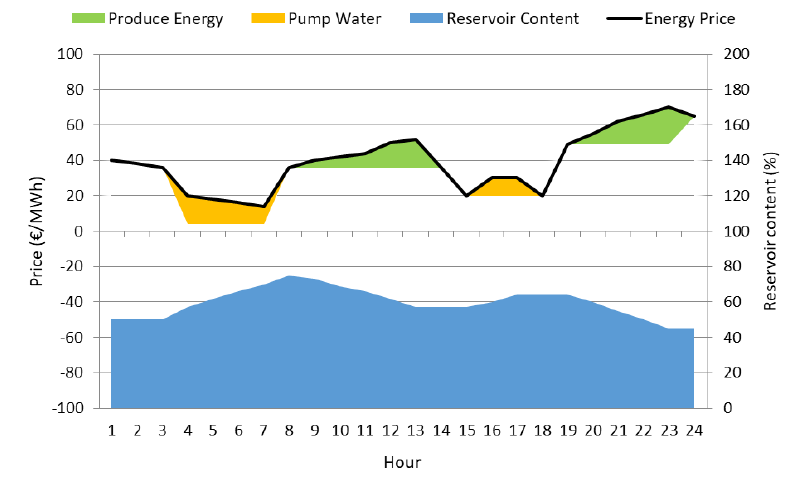
Figure 1. Typical operation of hydro plants that have a